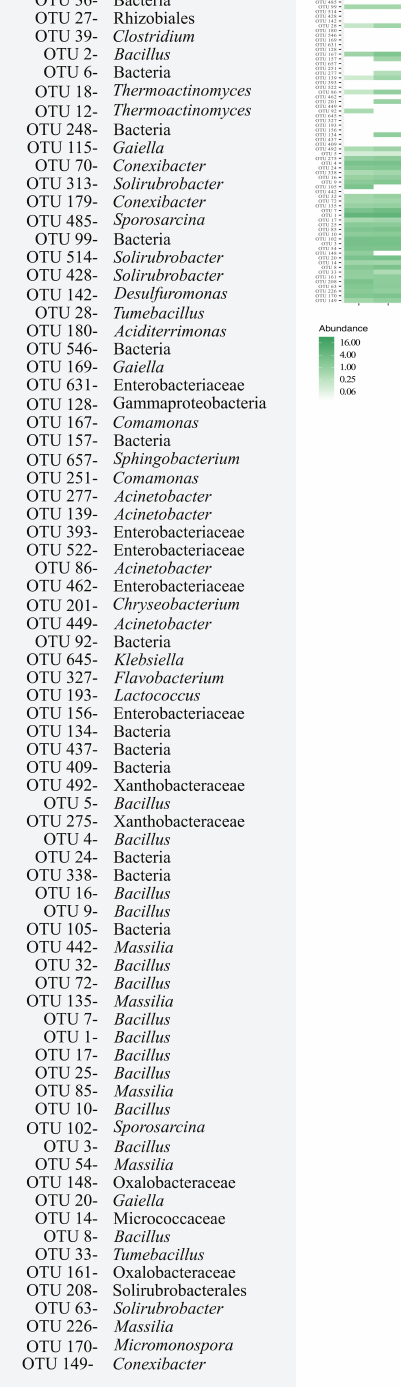
Figure 6. Heatmap for the most heavily represented OTUs (30 most abundant) of Lufa 2.2 soil with the presence of the soil invertebrate E. crypticus after exposure to each scenario for 48 h. The color codes represent the relative abundance of OTUs in each soil replicate ( n = 3). Standard refers to the conditions recommended by the standardized OECD guidelines. The symbol * indicates statistical differences compared to standard conditions based on one-way ANOVA followed by Dunnett’s post hoc test ( p ≤ 0.05). UV